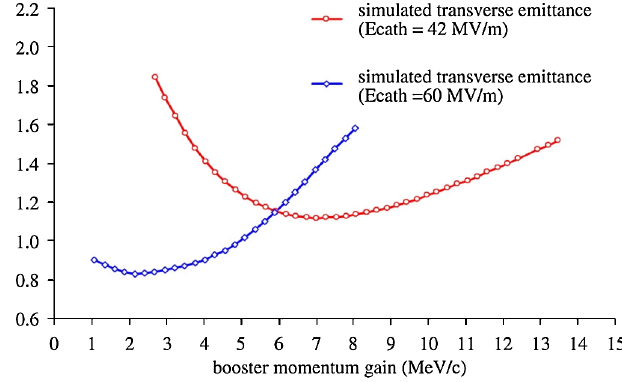
.FIG. 34. (Color) Simulated normalized beam emittance vs beam momentum gain in the booster for two gun gradients.